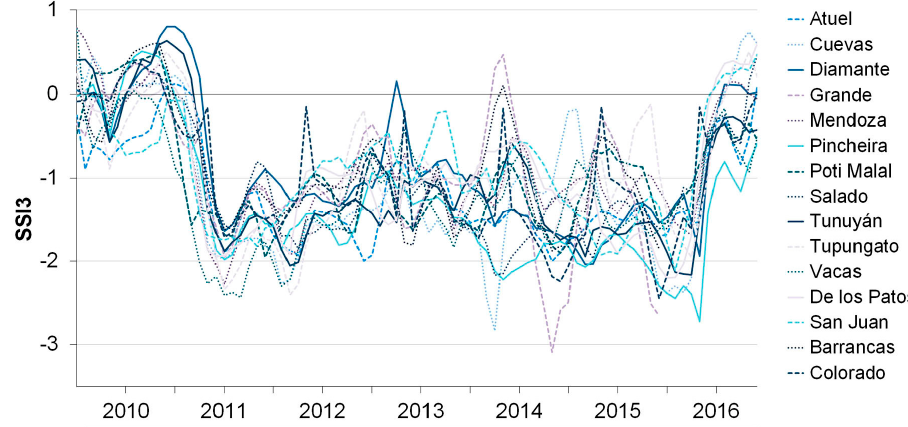
Figure 7. SSI3 evolution from July 2009 to June 2016 for the 15 stations located across the Central Andes of Argentina.